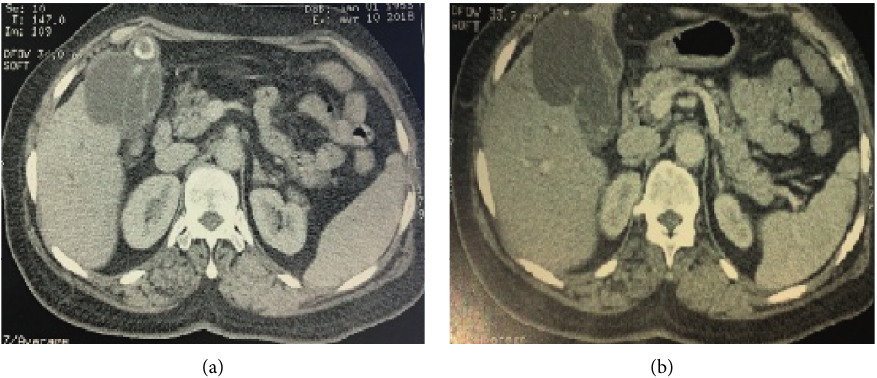
Figure 1: (a, b) Computed tomography (CT) scan showing a fistula between hydatid cyst and gallbladder.